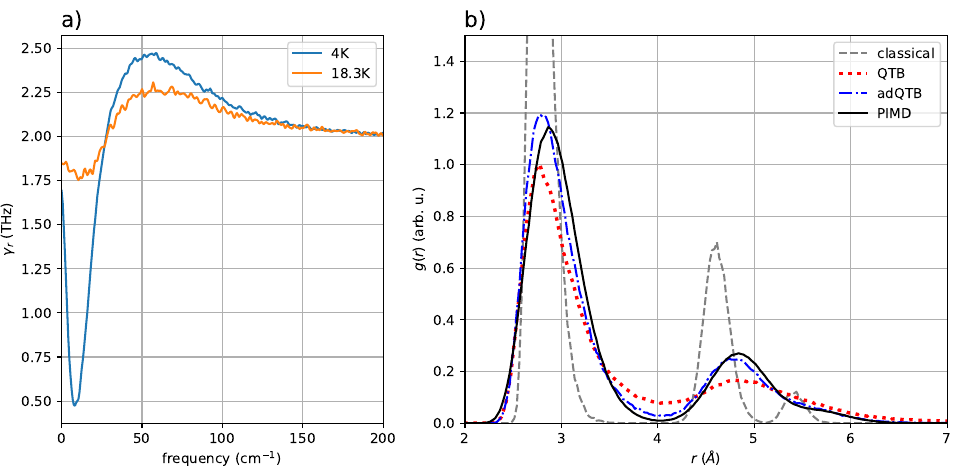
Figure 13. Panel ( a ) Adapted γ r ( ω ) for the Ne 13 clusters of [17] at 4 K (blue) and 18.3 K (orange). Panel ( b ) Radial pair distribution function g ( r ) for the QTB (dotted red) and adQTB (dash-dotted blue) compared to classical (dashed grey) and PIMD (solid black) at 4 K (results converged using 32 beads). The friction coefficient was set to γ = 2 ps − 1 in all